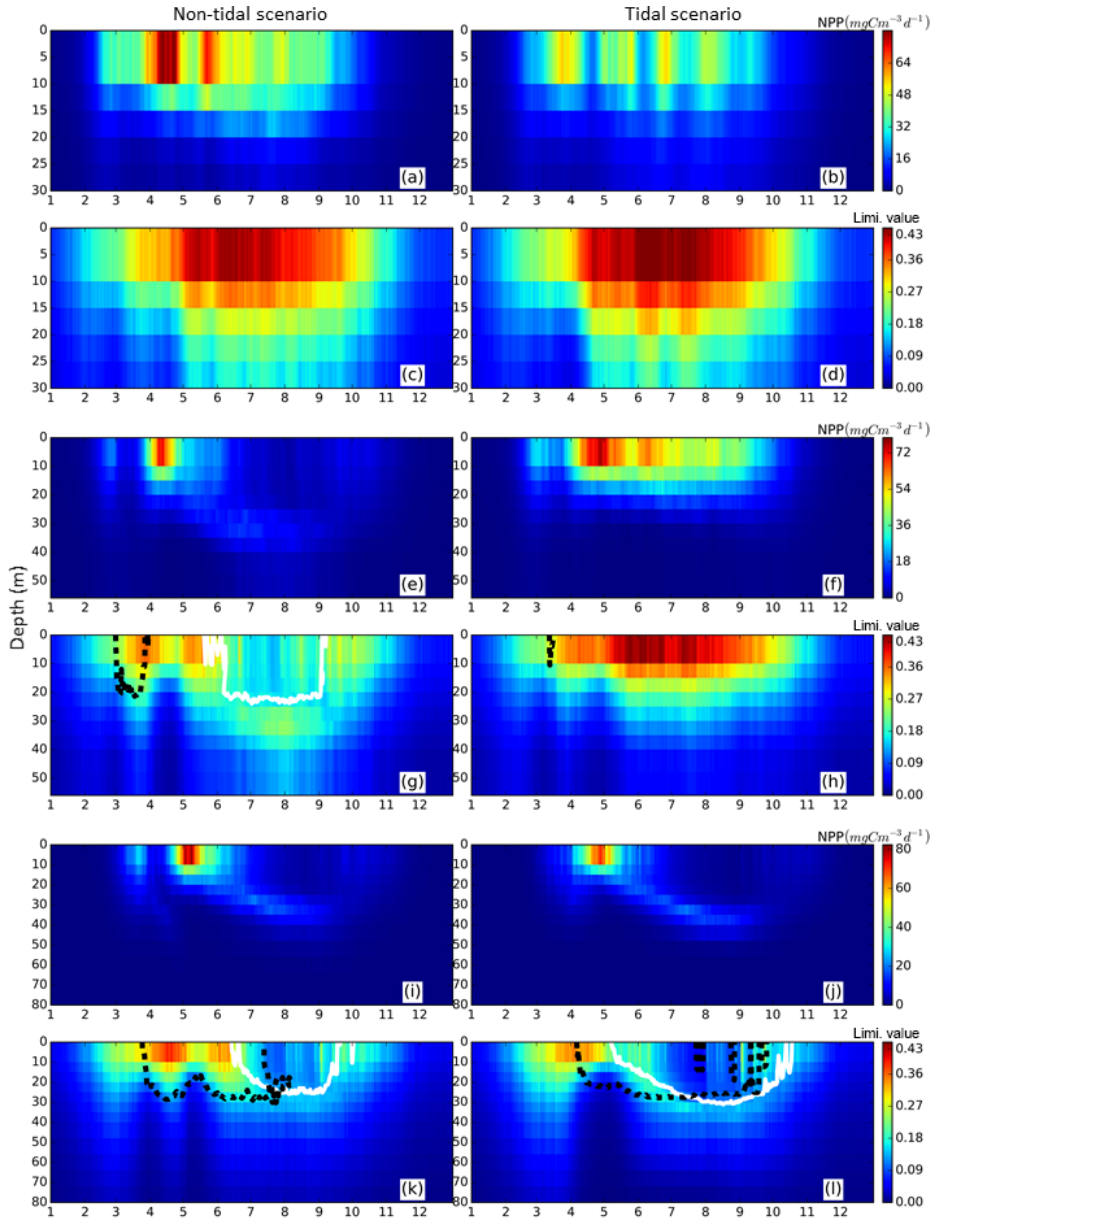
Figure 6. Time series of averaged (1990–2015) NPP vertical profiles (upper panels for each representative grid cell) and the limiting value (lower panels for each representative grid cell) for the tidal (right) and non-tidal (left) scenarios. NPP and limiting values are presented as the mean of each representative point for three subdomains, i.e., neg. SNS, the negatively responding southern North Sea (a–d) , pos. SNS, the positively responding southern North Sea (e–h) and deep NNS, the deeper northern North Sea (i–l) . Additionally, the depth above which a specific nutrient (silicate: solid black line, nitrogen: dashed white line) is limiting to NPP is given.